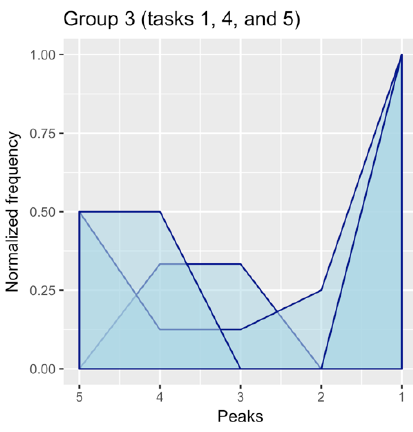
Fig. 10. Group combining learning curve for tasks 1 (Perform login), 4 (View accessibility evaluation form sample), and 5 (View the "about page" presentation). This group sums up to 25 observations.